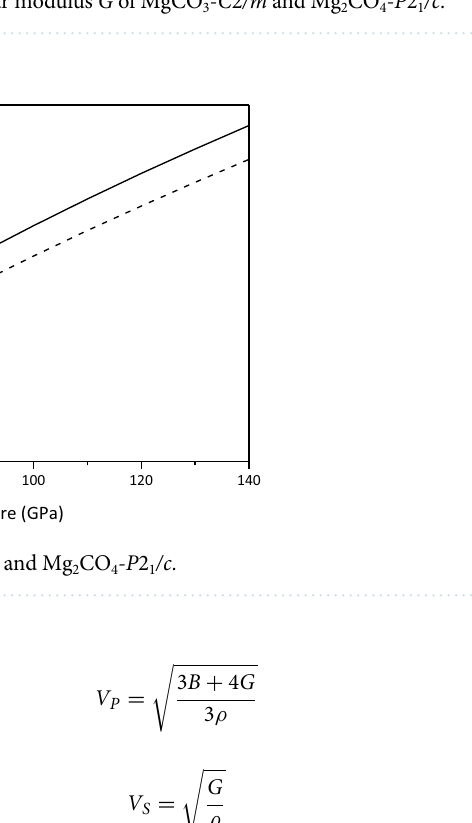
Figure 6. Bulk modulus B and shear modulus G of MgCO 3 - C 2 /m and Mg 2 CO 4 - P 2 1 /c .